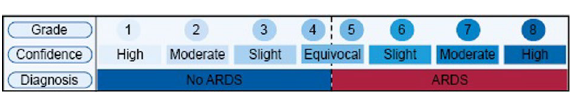
Figure 1. The 8-grade confidence scale. The expert scored a certain grade for each available image. The upper row displays the grades the expert scored, where the middle row indicates how the confidence of this grade should be interpreted. The row below indicates the cor- responding diagnosis.